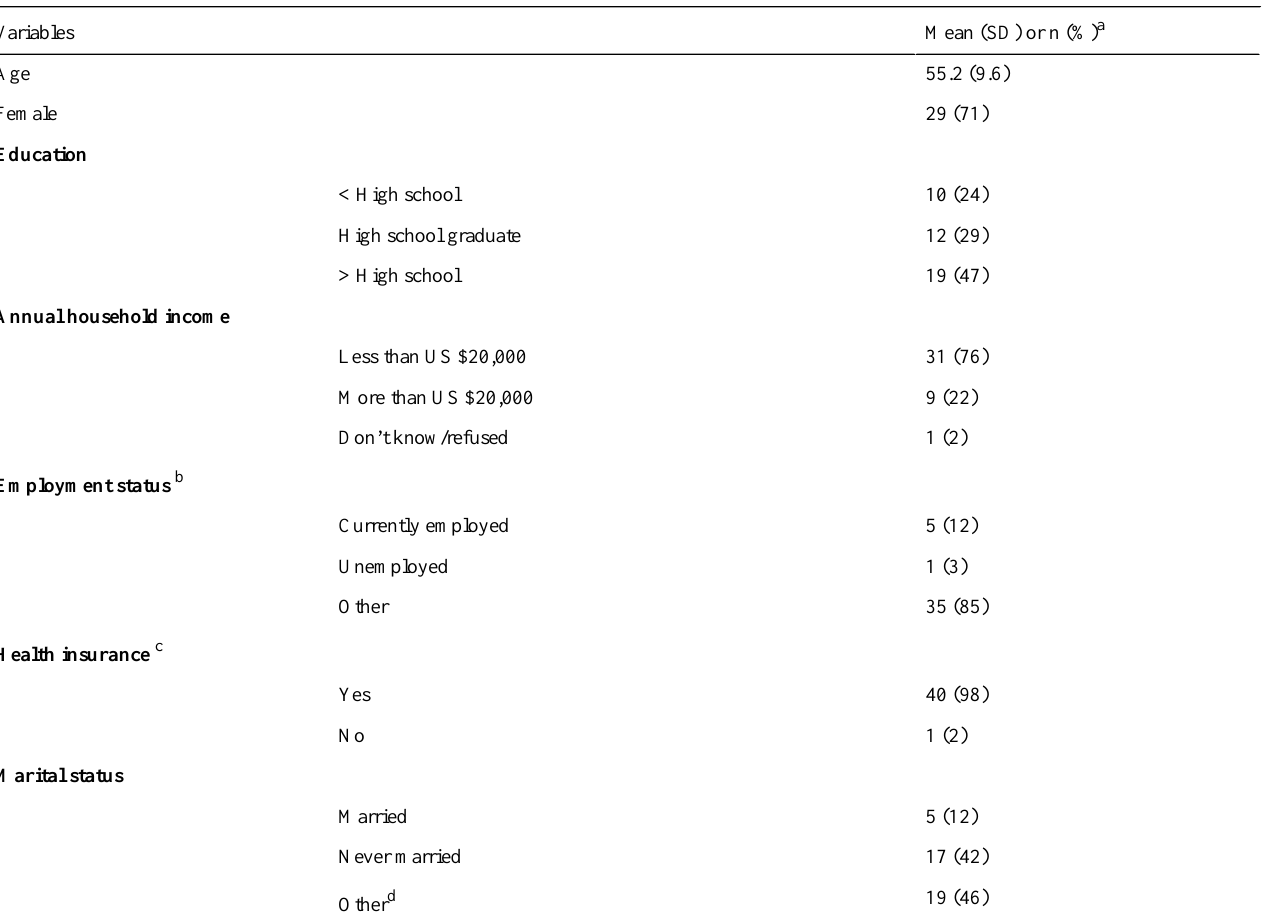
Table 1. Characteristics of the study participants